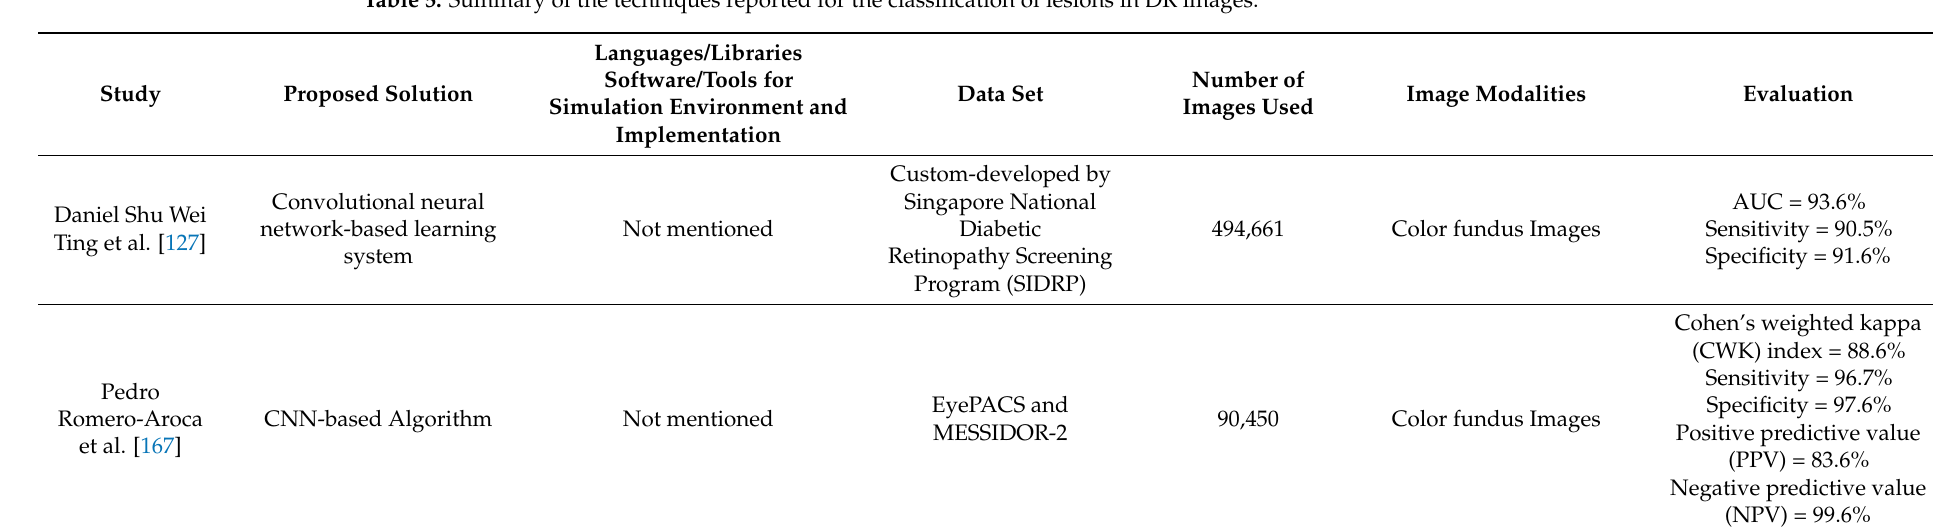
Table 5. Summary of the techniques reported for the classification of lesions in DR